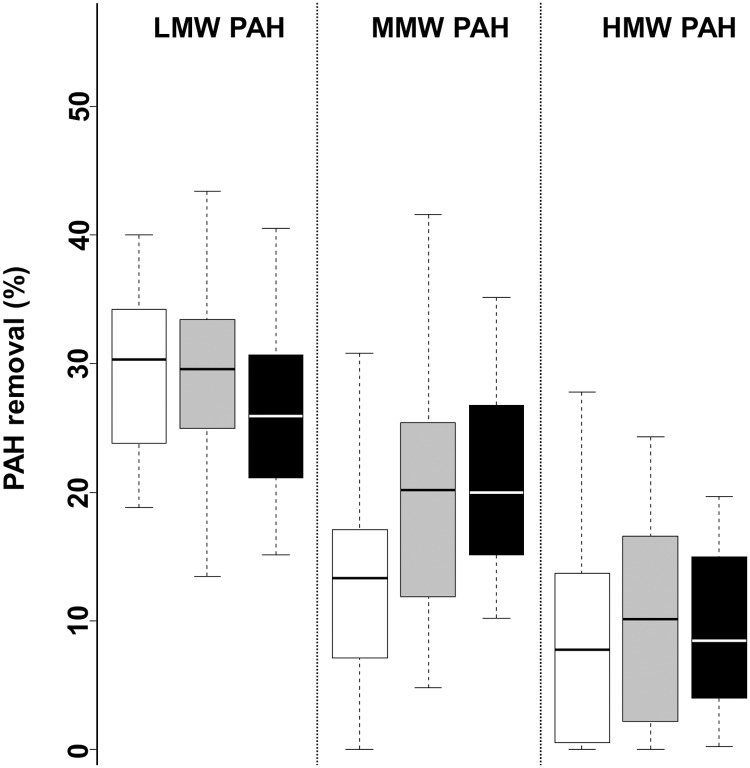
Boxplot of the anaerobic pollutants removal at steady state according to the inocula.The removals for eco1 (white), eco2 (grey) and eco3 (black) were measured at steady state. The LMW-PAH, the MMW-PAH and the HMW-PAH are defined in Table 1. The box shows 75th percentiles (top line), 50th percentile (middle line) and 25th percentile (bottom line).